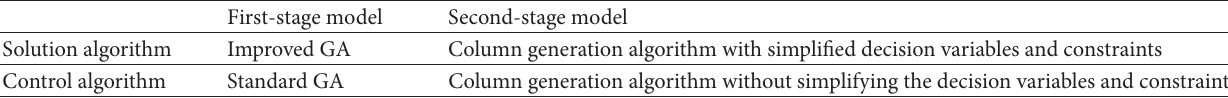
Table 3: Relationships between solution and control algorithms.